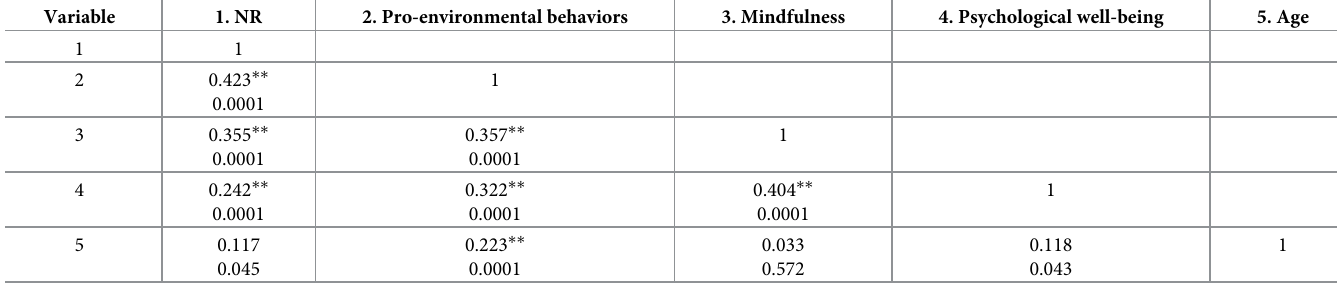
Table 8. Correlation matrix between NR and dependent